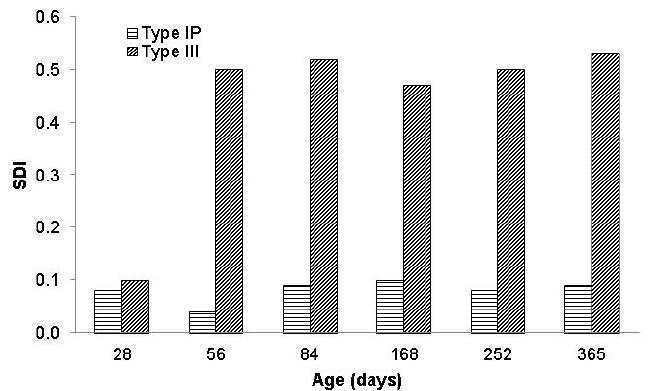
Figure 17. Stiffness Damage Index (SDI) of concretes over time.